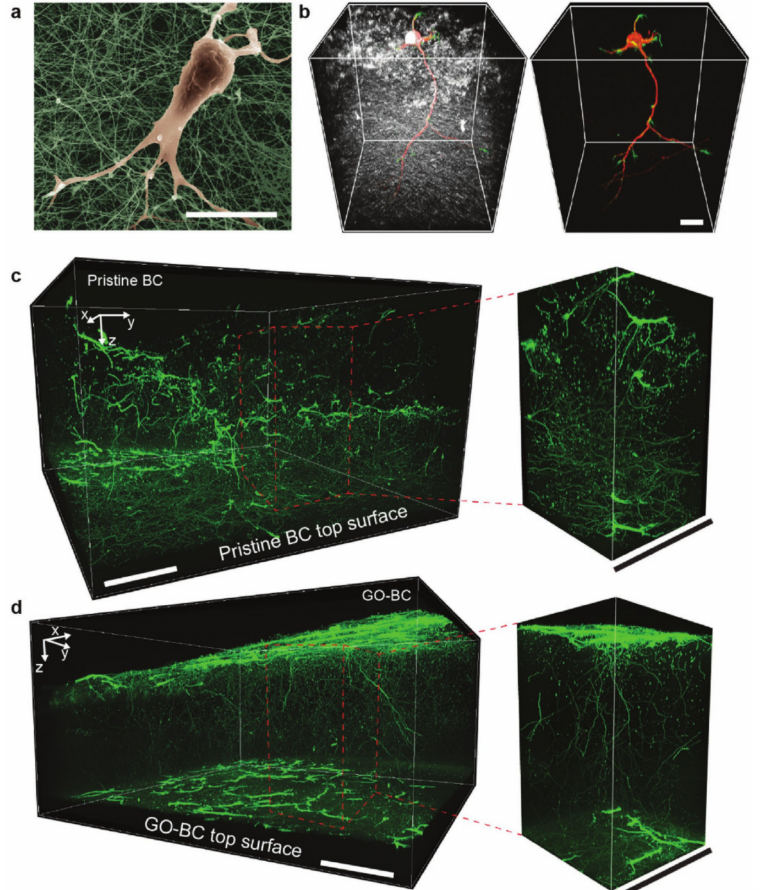
Figure 5. Pseudo-colored SEM image of an E18 neuron seeded on neat BC ( a ) 3D confocal fluorescence images of an E18 neuron development inside neat BC sca ff olds ( b ) 3D confocal fluorescence images of Tuj1 red and Phalloidin green-stained neurons cultured on neat BC ( c ) and BC / GO hydrogels ( d ) [93]. Reproduced with copyright